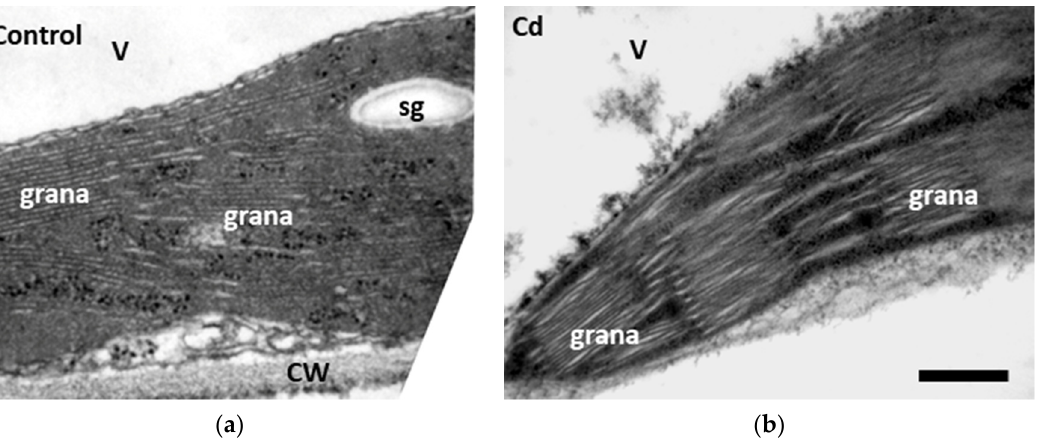
Figure 6. Transmission electron microscopy (TEM) images of chloroplasts from control (nutrient solution) ( a ) and 8-day Cd 2+ -treated (nutrient solution + 100 μΜ Cd 2+ ) ( b ) Salvia sclarea leaves. Upon Cd treatment, chloroplasts appeared electronically dense and with swollen thylakoids, while being devoid of starch grains when compared with control. CW : cell wall; sg : starch grain; V : vacuole. Scale bar: 200 nm.